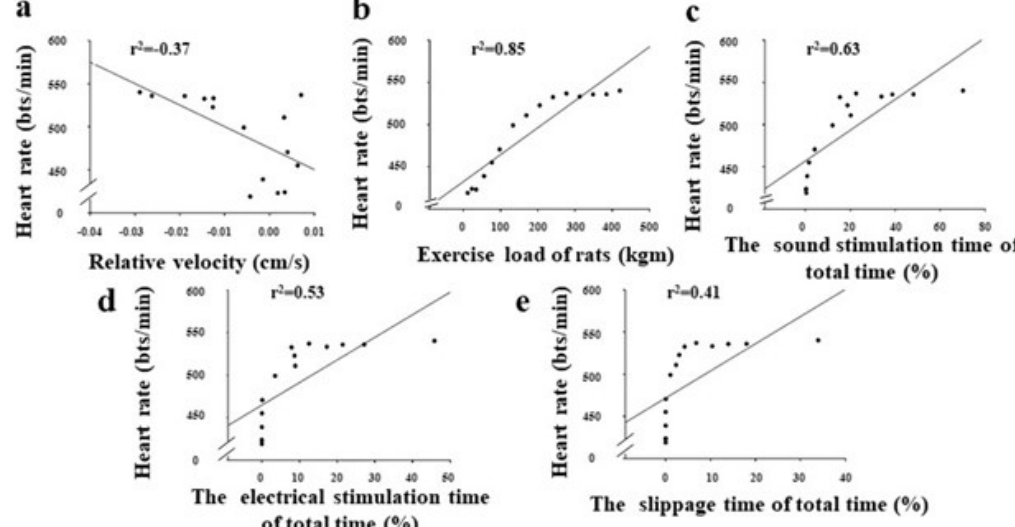
Figure 8 - Correlation analysis of heart rate and exercise load, ethological indexes.